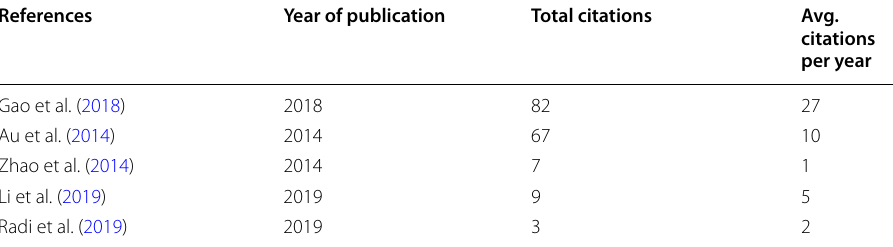
Papers which incorporate multiple UCs are grouped into the Multiple entry Table 2 Citations per year for the billing use case: all papers of the exemplary billing use case with their respective citation metrics according to Google Scholar as of the time of